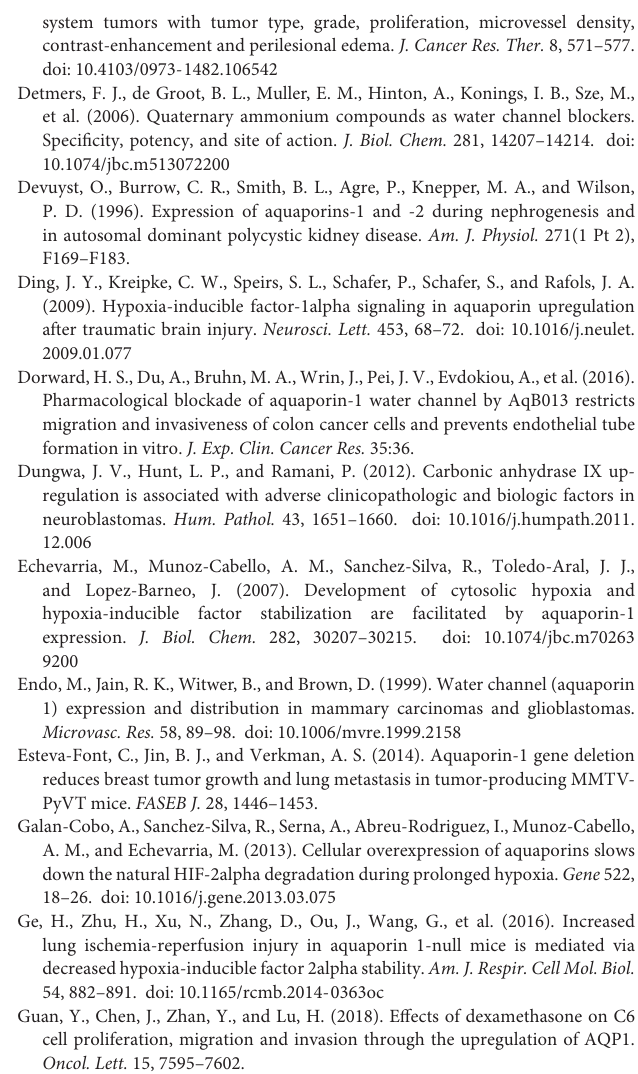
stimulus in confocal microscopy (left lower panel: fluorescence at 488 nm; upper right panel: phase contrast; lower right panel: overlap). The film demonstrates the enormous shape changes enhancing their ability to move through confined spaces. This requires major water fluxes across the membrane, which are greatly facilitated by the presence of aquaporin. Although the water efflux is not solely due to aquaporin 1 water channels, we show in the stopped-flow spectroscopy ( Figure 2B ) that aquaporin expression is functional and accelerates water